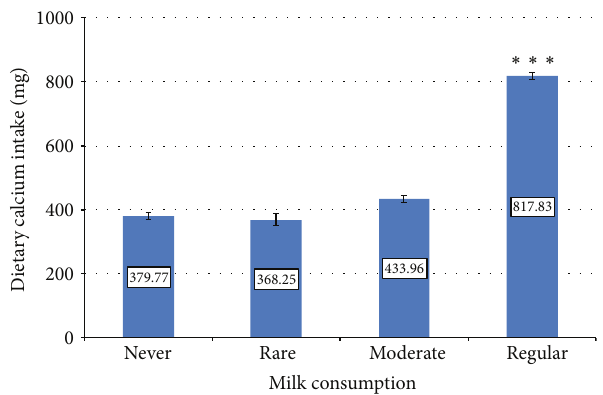
Figure 1: Therelationship between thevolumeof milk consumption and daily calcium intake ( 𝑃 < 0.001 ): the higher was the daily milk consumption, the greater became dietary calcium intake. Note . Low milk consumption: never or less than a glass (two deciliters) of milk per week (rare); moderate milk consumption: less than half a glass (one deciliter) of milk a day; regular milk drinkers: more than half a glass (one deciliter) of milk daily. ∗∗∗ 𝑃 < 0.001 versus abstainers and subjects with low or moderate milk consumption.